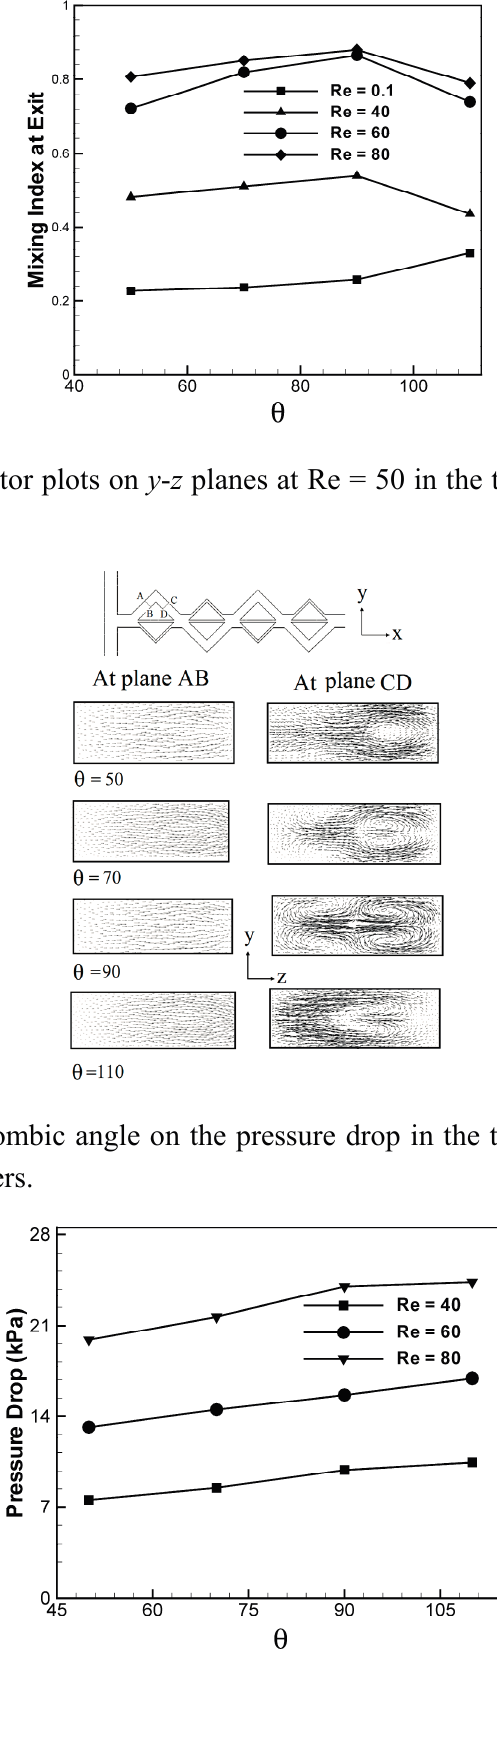
Figure 9. Effect of rhombic angle on mixing in the three-split micromixer for various Reynolds numbers.